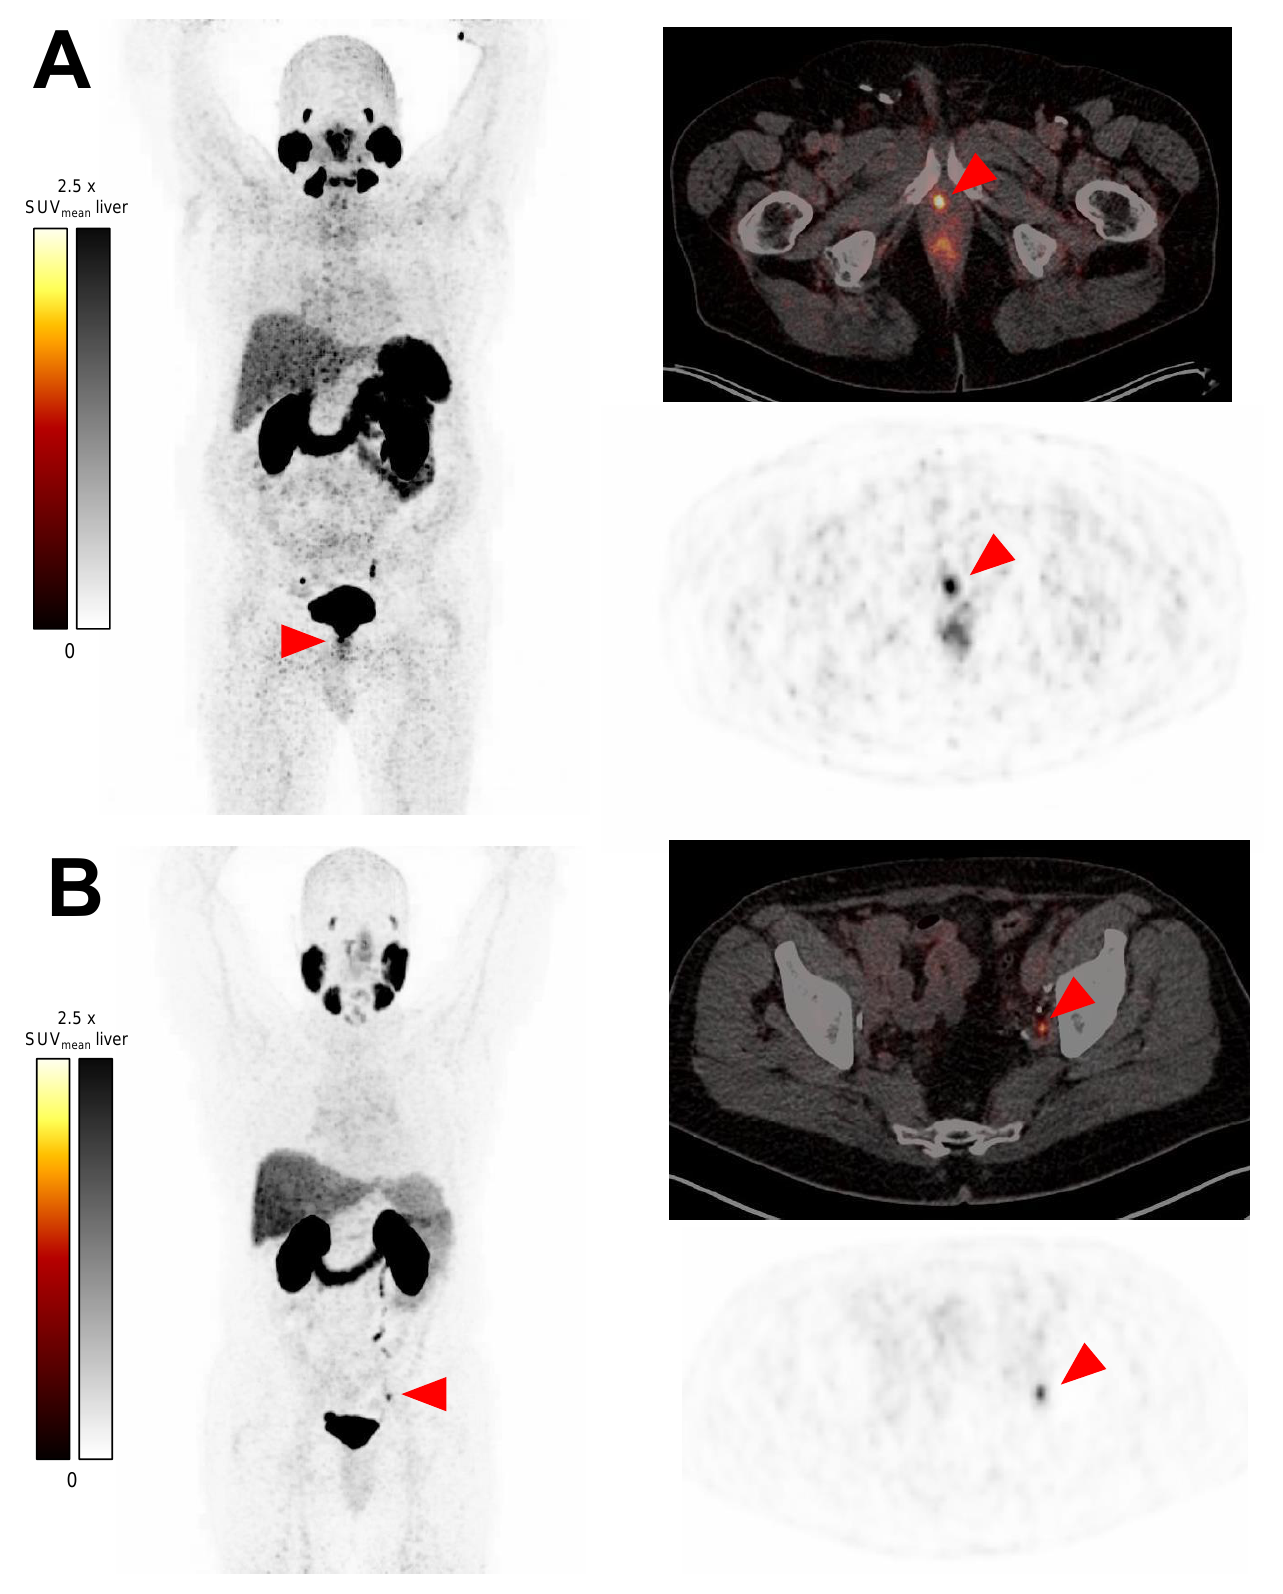
Figure 1. Representative 68 Ga-PSMA-11 PET/CT transversal slice PET images (upper right-hand scans) and PET/CT fusion images (left-hand and lower right-hand scans) of suspicious lesions: ( A ) putative local recurrence in a 71-year-old man with a PSA concentration of 0.10 ng/mL and ( B ) a putative left iliac lymph node metastasis in a 67-year-old man with a PSA concentration of 0.13 ng/mL.